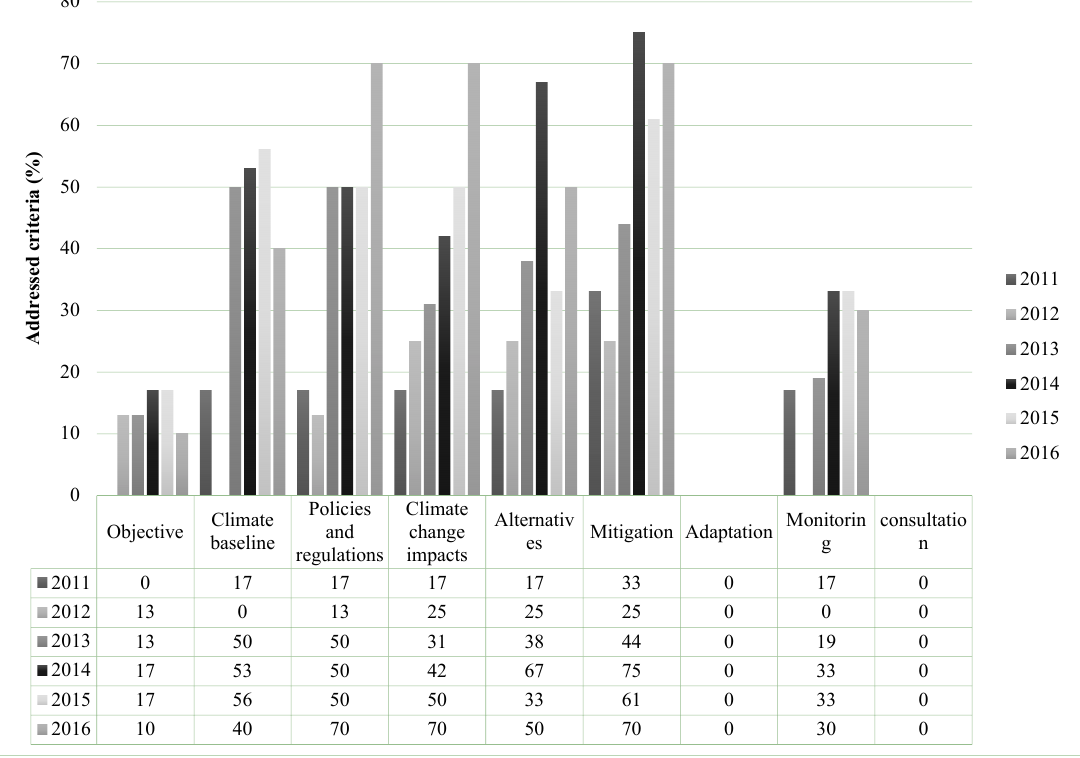
Figure 2. Percentage of criteria addressed (2011–1016).